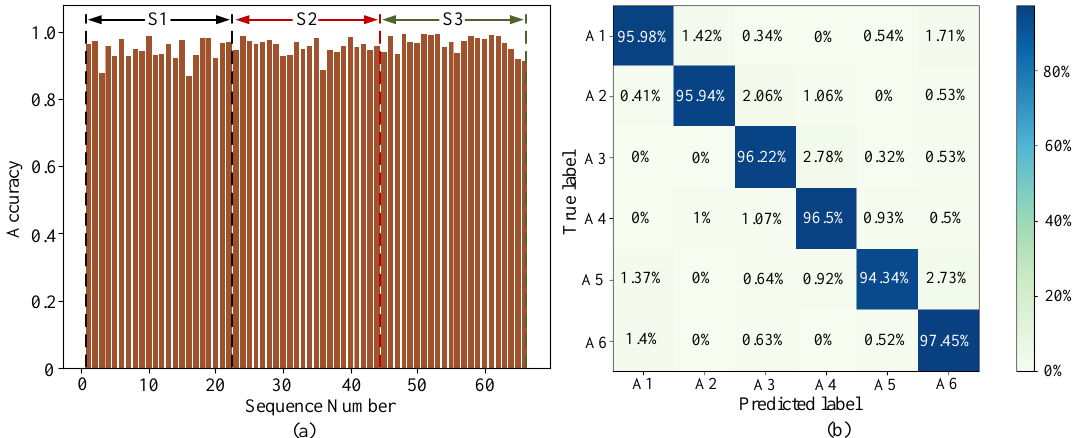
Figure 19. ( a ) The recognition accuracy and ( b ) confusion matrix of Bi-LSTM after multi-frequency